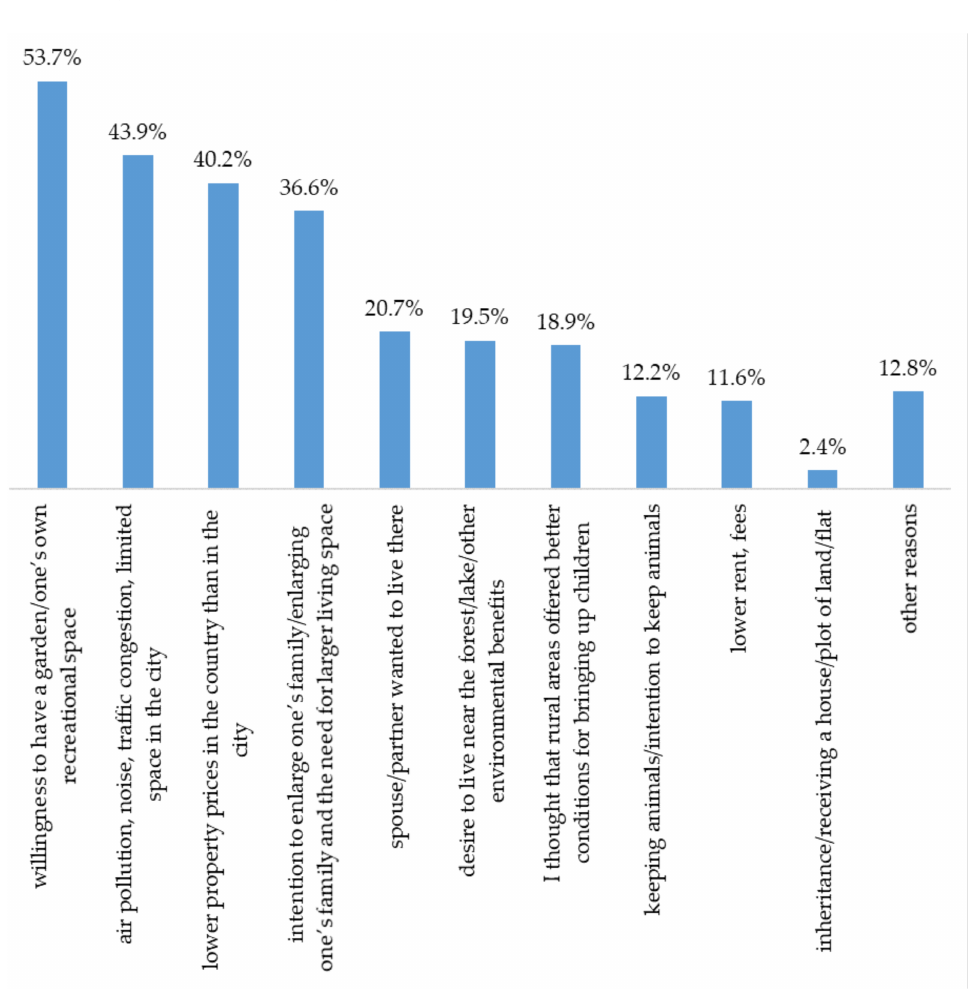
Figure 3. Reasons for moving from the city to the countryside. Source: own study based on research